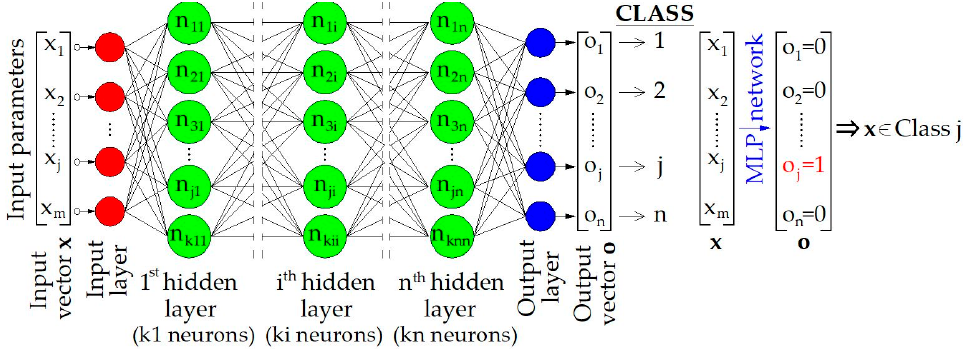
Figure 2. General form of an MLP network configured for the solution of classification problems.